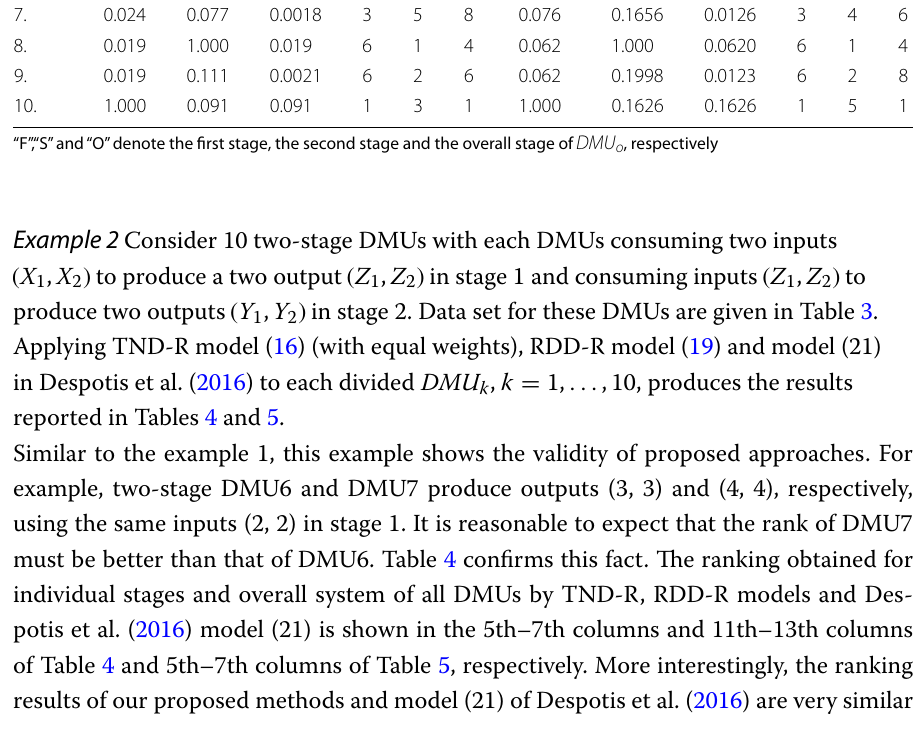
“F”,“S” and “O” denote the first stage, the second stage and the overall stage of DMU o , respectively